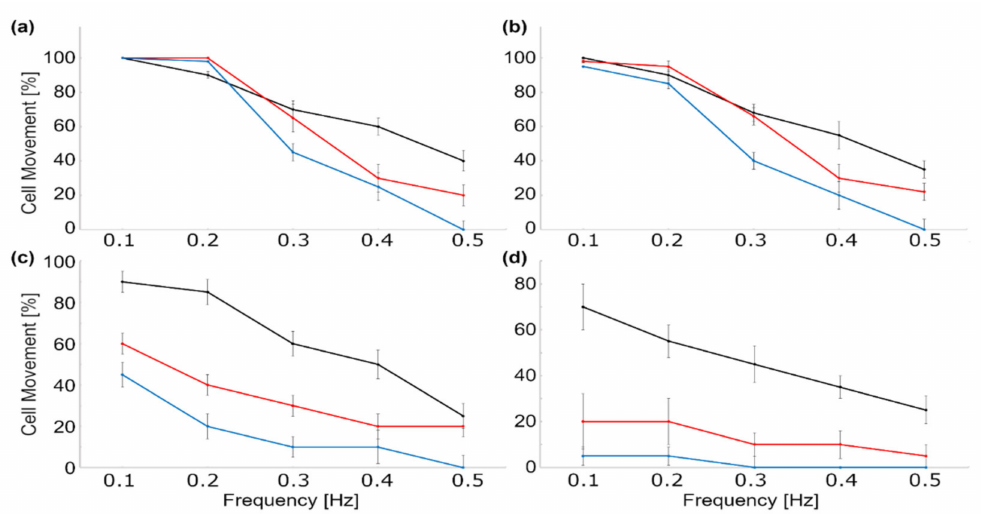
Figure 12. The experimental results showing the percentage of the AML (black and blue) and T cells (red) labeled with three different magnetic particles (see text for the details) moving on magnetic tracks in magnetophoretic circuits ( a ) 0, ( b ) 6, ( c ) 24, and ( d ) 48 h after magnetic